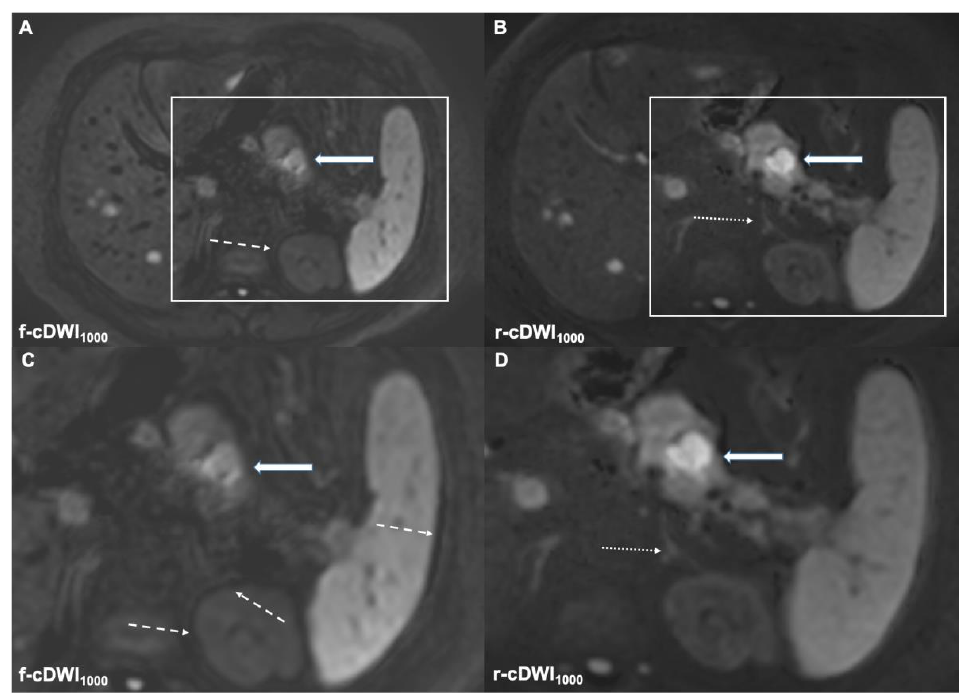
Figure 1. The high-resolution rFOV-DWI ( B , D ) yields better overall image quality compared to the conventional fFOV-DWI ( A , C ). Reduced distortion and motion artifacts enable better tumor delineation in the r-cDWI1000 (bold arrow in ( B , D ). Increased misregistration artifacts are depicted in the f-cDWI1000 images (dotted arrows in ( A , C )). Additionally, note the better delineation of the left adrenal gland in the r-cDWI1000 images (dotted arrow in ( B , D )).